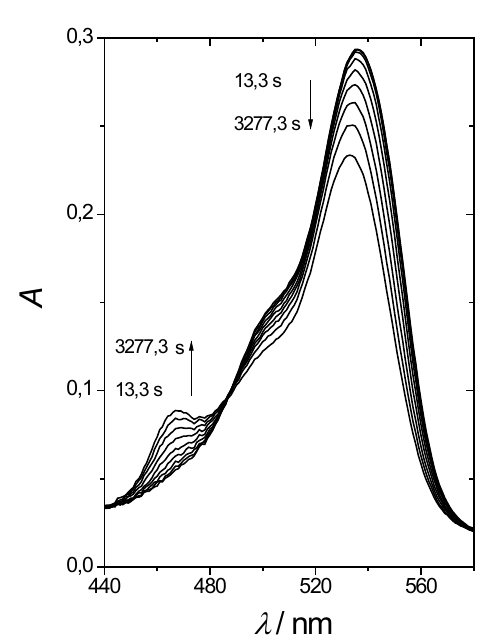
Figure 3. Absorption spectra of rhodamine 6G / montmorillonite colloids measured at certain times after the mixing the